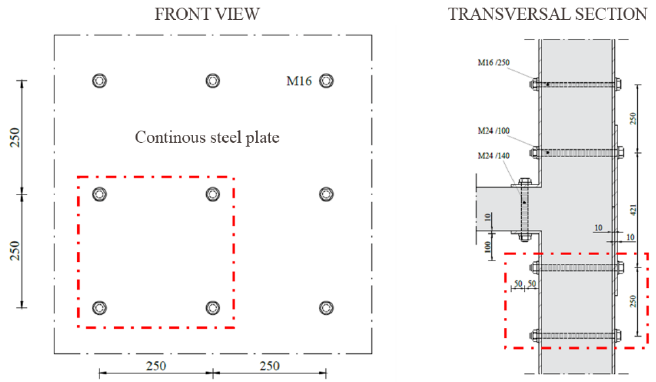
Figure 13. Structural detail of the continuous steel plate reinforcement.